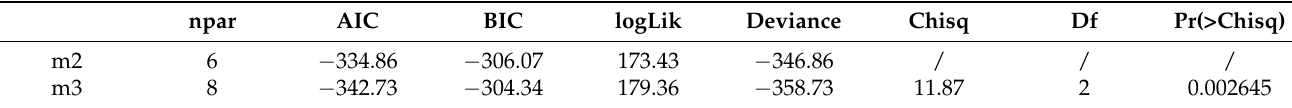
Table A3. Effect of treatment on the growth rate in plant